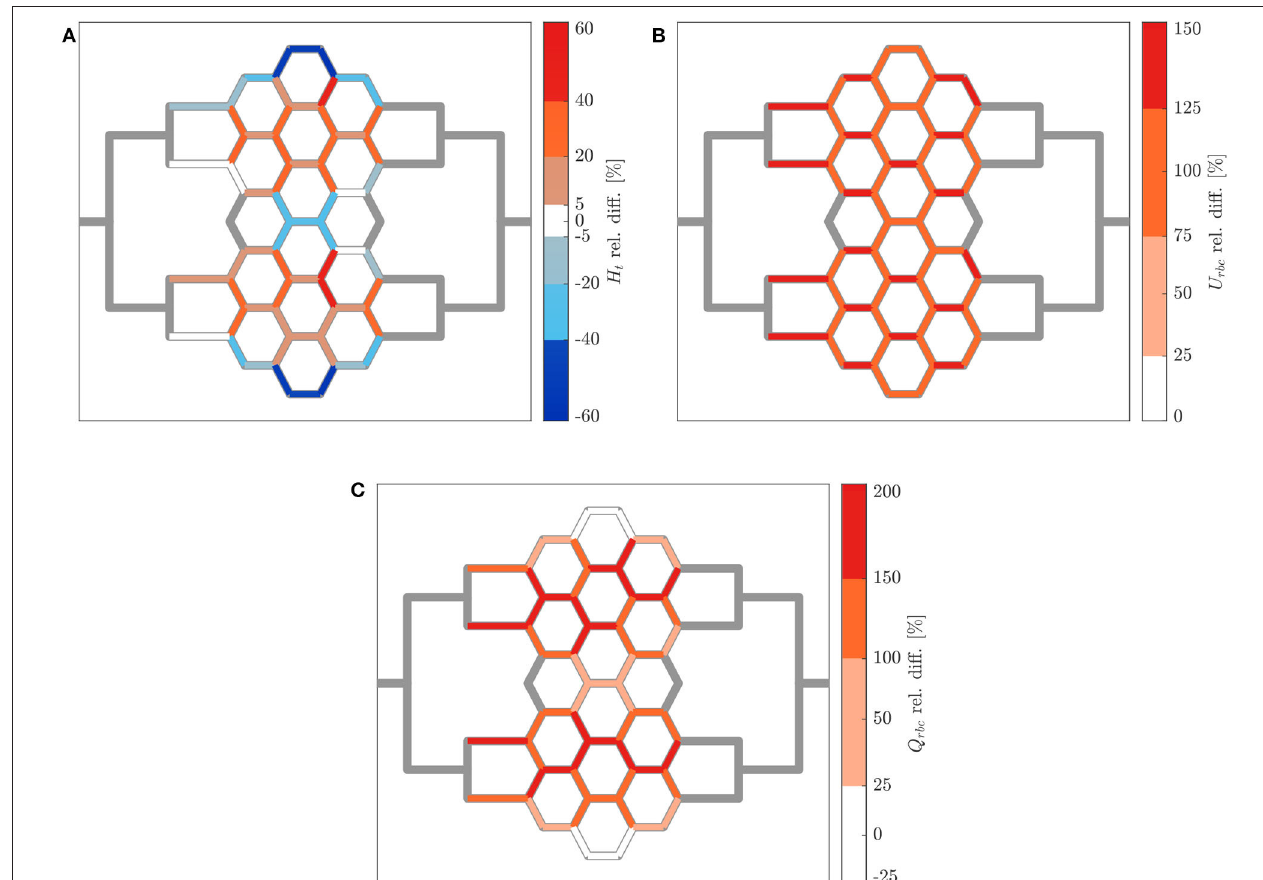
FIGURE 9 | Hematocrit, RBC velocity and flux relative difference for arteriolar activation. Relative hematocrit (A) , RBC velocity (B) , and flux (C) difference for individual micro-channels of the honeycomb network between the activation of an upstream arteriole modeled by increasing the pressure difference between inlet and outlet of the honeycomb network ( 1 P 19.6 mbar , p 0 bar ) and the control case ( 1 P 9.8 mbar , p 0 bar ). Flow direction is from left to = = = =